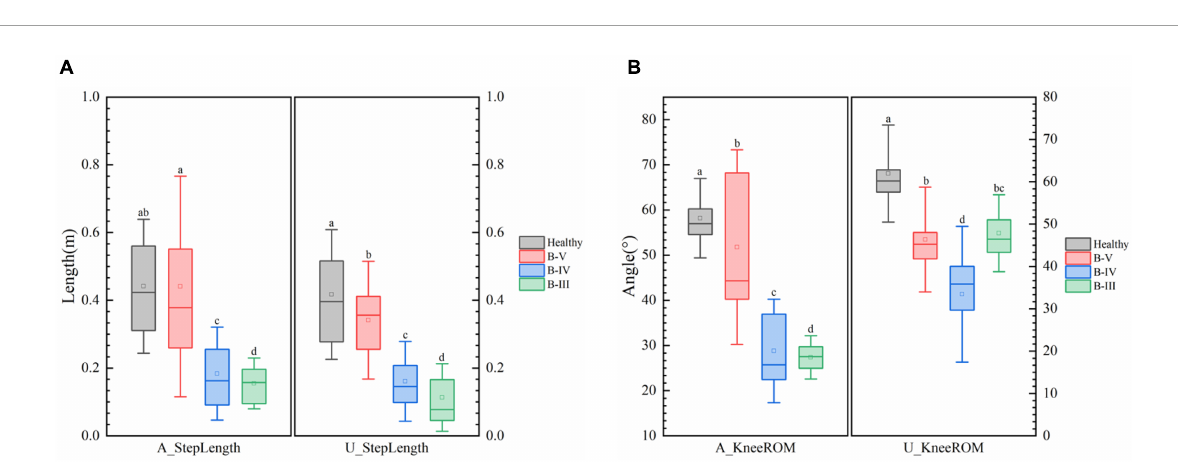
FIGURE4 (A) Comparison of step length and (B) knee range of motion (ROM) in patients with different degrees of hemiplegia. Different low case letters above columns indicate statistical differences at P <